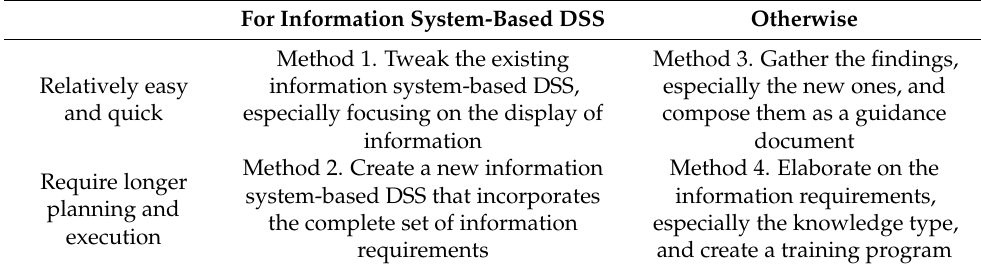
Table 5. Information requirements application